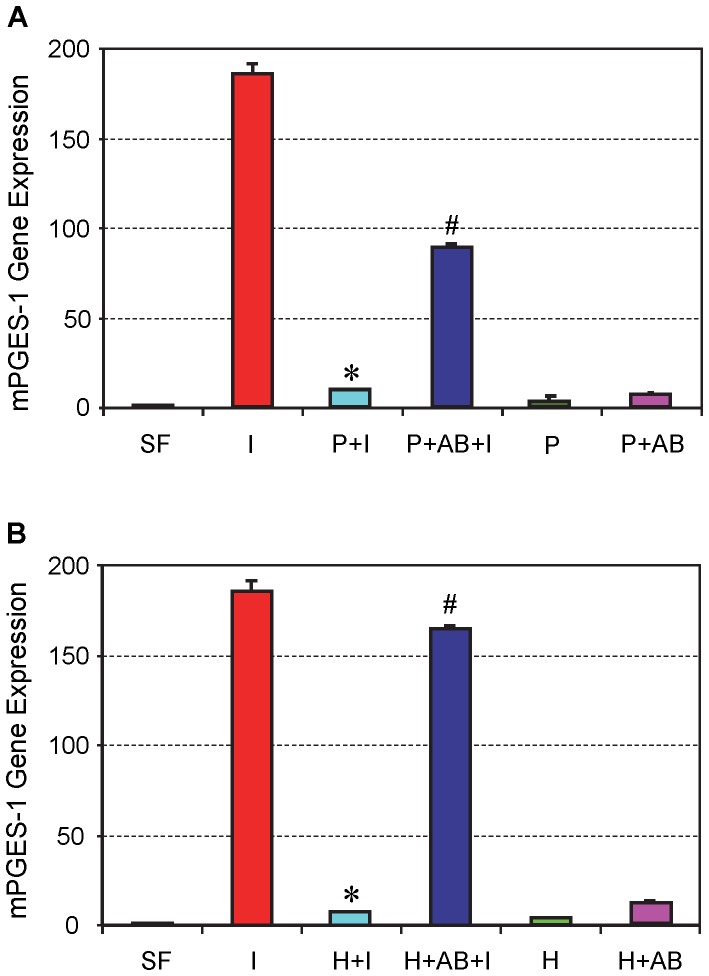
The effects of PRP (A) and HGF (B) treatment on mPGES-1 gene expression in tendon cell culture.IL-1β treatment increased mPGES-1 expression (I), but its effect was almost completely suppressed by PRP (A) or HGF (B) treatment. Note that *P<0.05 is with respect to IL-1β treatment condition (I); and #P<0.05 is with respect to the PRP+IL-1β (P+I) group in A and the HGF+IL-1β (H+I) group in B. The data are expressed as mean ± SD, n  = 4. Label abbreviations and concentrations of all agents (IL-1β, PRP, HGF, and HGF antibody) are identical to legends in
Figure 2
. For SD values that are barely visible, the variation in gene expression values was less than 5 (control group, SF is 1).